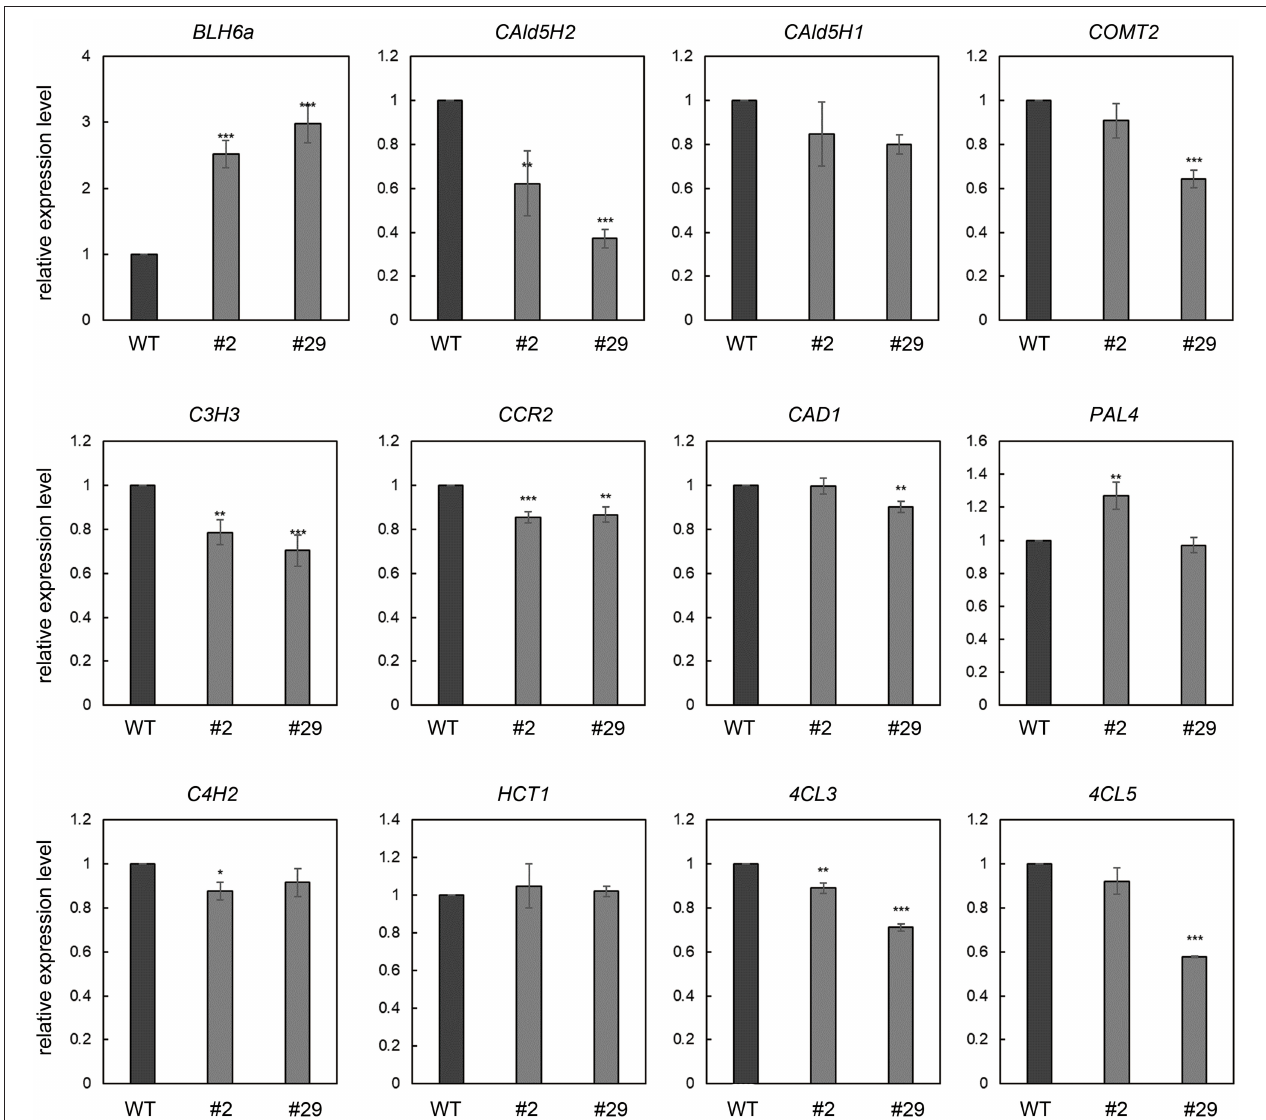
FIGURE 6 | qRT-PCR analysis of monolignol pathway genes in the differentiating xylem of BLH6a:SRDX overexpression transgenic P. alba × P. glandulosa . The transcript abundance in wild type (WT) and transgenic lines 2 and 29 was determined for transgene BLH6a:SRDX and monolignol pathway genes CAld5H2 , CAld5H1 , COMT2 , CAD1 , C3H3 , CCR2 , C4H2 , 4CL3 , 4CL5 , PAL4 , and HCT1 . Asterisks highlight significant differences by the Student’s t -test: * p < 0.5, ** p < 0.01; *** p <